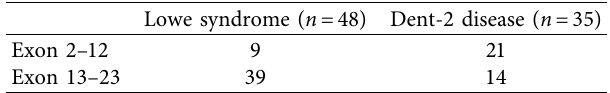
Table 4: Different mutation locations from Lowe syndrome and Dent-2 disease.